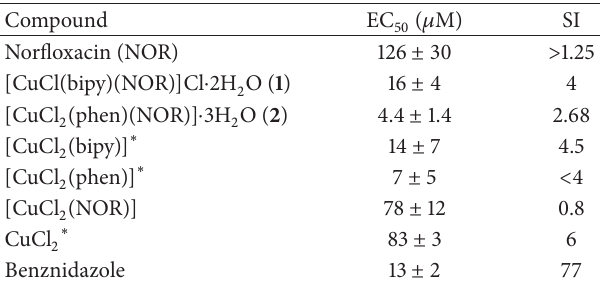
SD: standard deviation of multiple experimental measurements. SI: selective index: ratio between LC 50 /EC 50 values. LC 50 : drug concentration which reduces the viability of mammalian cell by 50 %